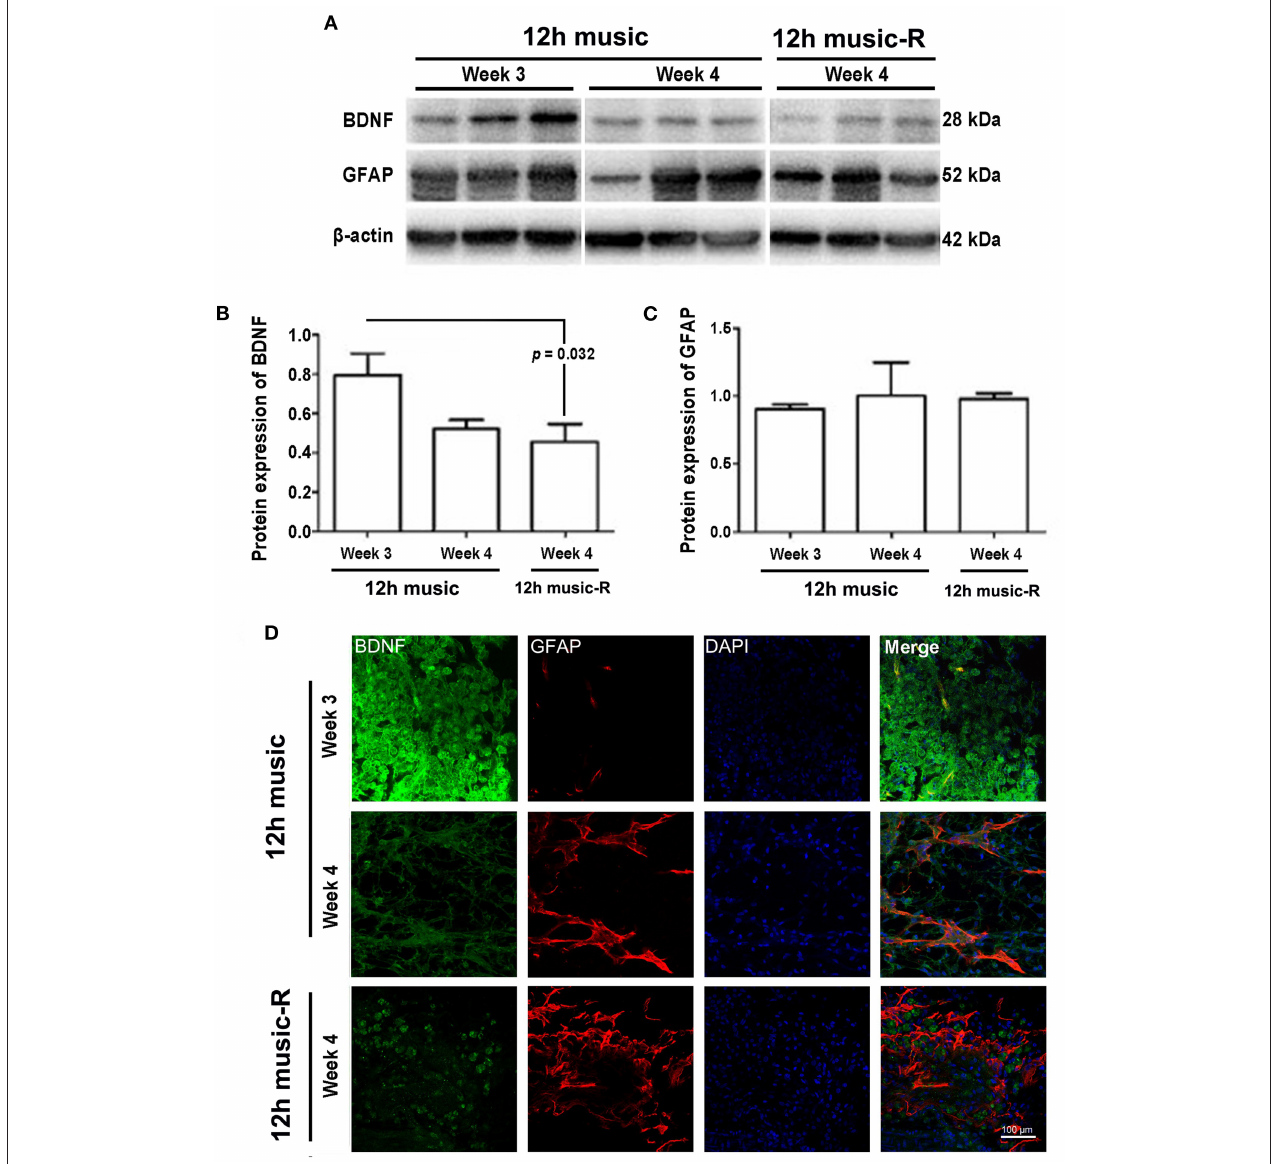
FIGURE 7 | Persistent effects of 12h music therapy on BDNF and GFAP expression. (A) Western blot analysis of BDNF in the lesioned area. Quantification of (B) BDNF and (C) GFAP examined by Western blot. (D) Relative fluorescence intensity of BDNF and GFAP in the motor cortex. Rats in the 12-h music group continually received the intervention for 3 weeks; those in the 12-h music-R group, for 2 weeks plus 1-week rest. BDNF and GFAP levels were examined at 3 and 4 weeks after